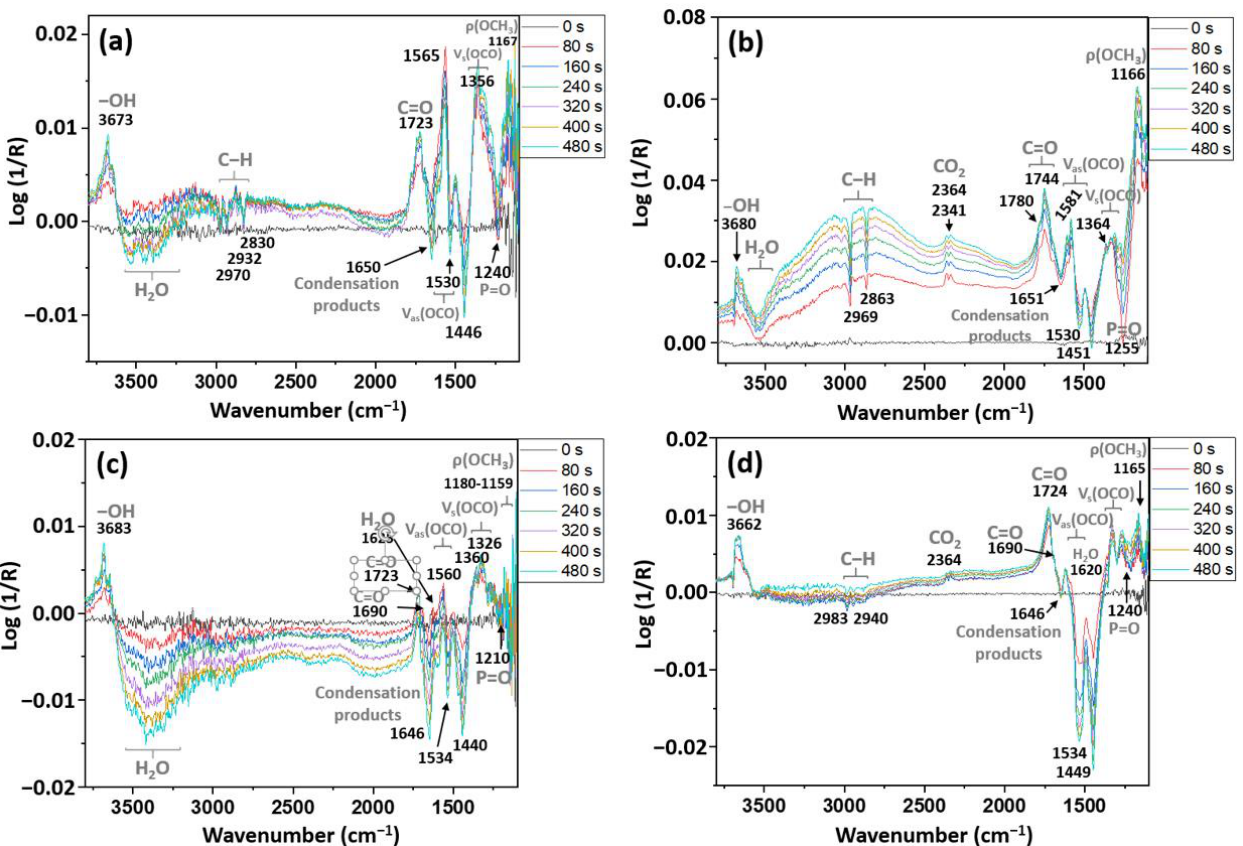
Figure 5. DRIFT spectra for UV illumination of TMP on ( a ) UV100 and ( b ) Ti-600 and of TEP on ( c ) UV100 and ( d ) Ti-600 at different time intervals. Positions and assignments for major absorption bands are indicated.